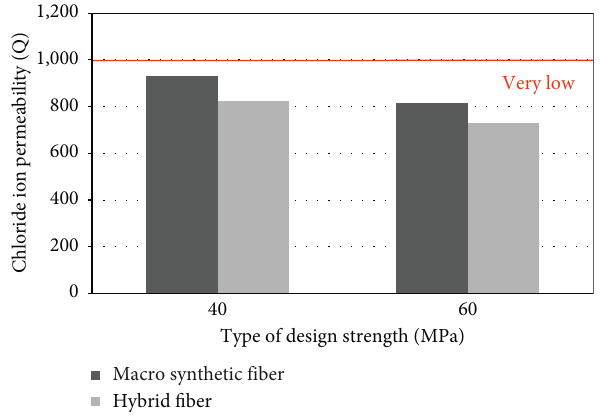
Figure 7: Chloride ion penetration of the optimum mixture.